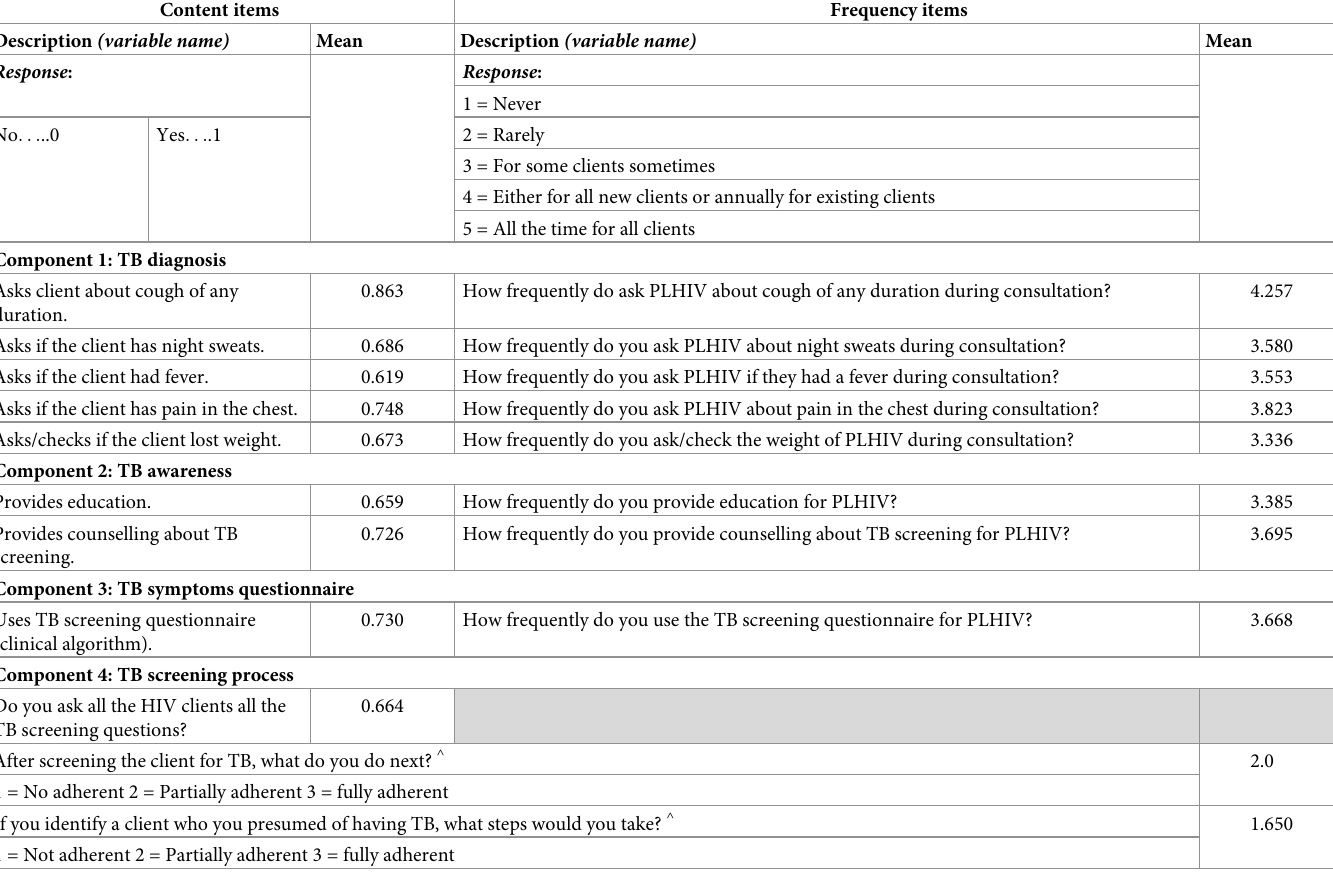
Table 1. List of the 19 items used to determine provider implementation fidelity score. Content